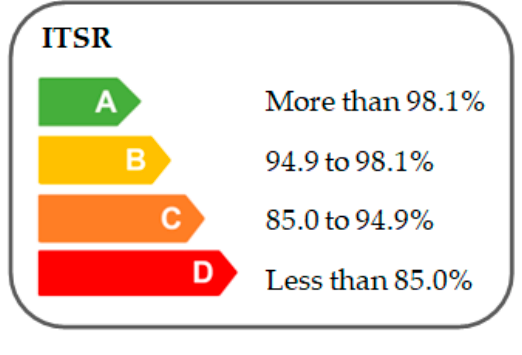
Figure 16. ITSR labels based on the type of mixture.